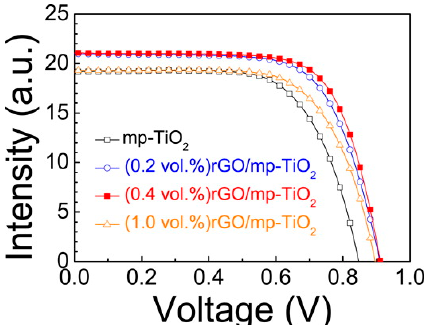
Figure 7. J-V curve of rGO/ mesoporous-TiO 2 nanocomposite based perovskite solar cell with varying